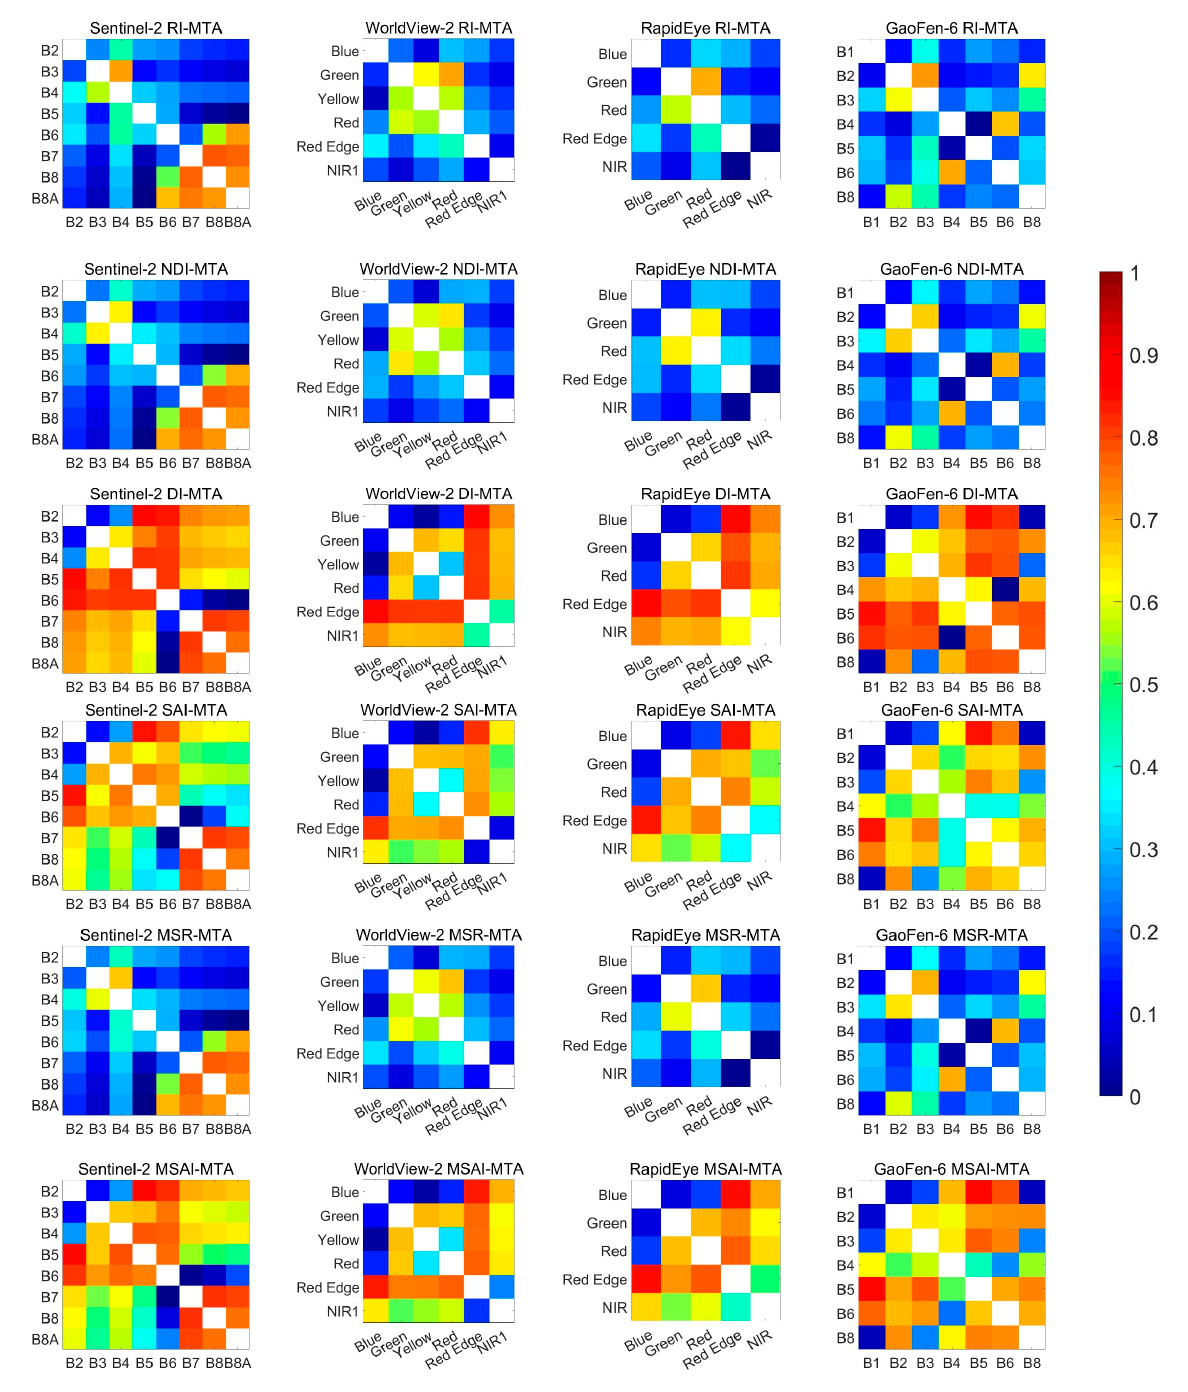
Figure A3. Map of the coefficient of determination between MTA ( R 2MTA ) and vegetation indices using all two band combinations based on RI, NDVI, DI, SAI, MSR and MSAI formulations. The color indicates different R 2 values.